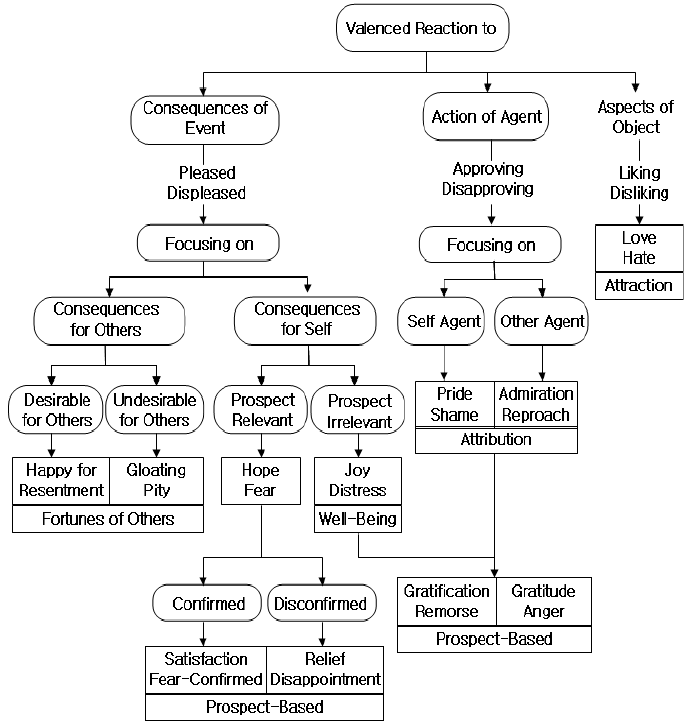
Figure 1. Ortony, Clore, and Collins ( OCC) model for emotion appraisal [7]. Table 1. Types and contexts of